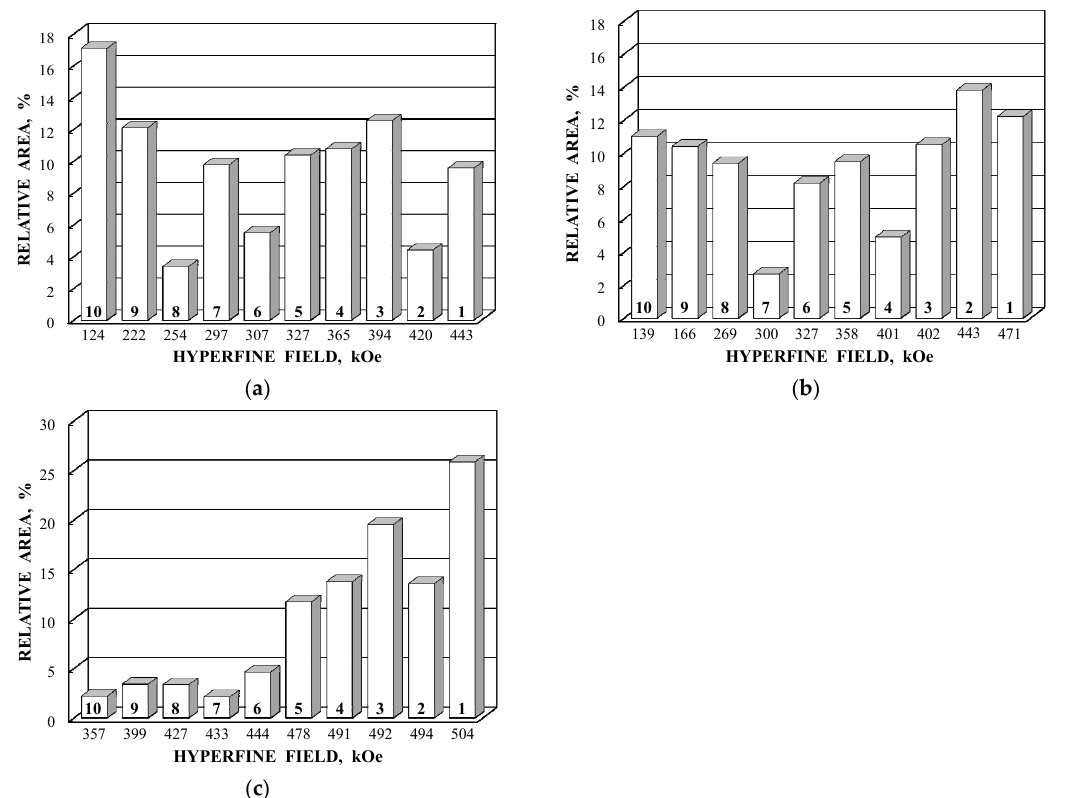
Figure 38. Mössbauer spectra of the γ‐ Fe 2 O 3 /Fe 3 O 4 –IMF ( a , b ) and γ‐ Fe 2 O 3 /Fe 3 O 4 –OAT ( c ) nanopar ‐ ticles measured at 295 K ( a , c ) and 90 K ( b ) in 4096 channels and converted into 2048 ‐ channel spectra for ( a , b ). Indicated components 1–11 ( a , c ) and 1–10 ( b ) are the results of the best fits. The differen ‐ tial spectra are shown on the bottom. Adapted from Ref. [72] with permission from Elsevier: Spec ‐ trochimica Acta, Part A: Molecular and Biomolecular Spectroscopy, Vol. 152, Oshtrakh M.I., Ush ‐ akov M.V., Šepelák V., Semionkin V.A., Morais P.C., “Study of iron oxide nanoparticles using Mössbauer spectroscopy with a high velocity resolution”, 666–679, ©2016.